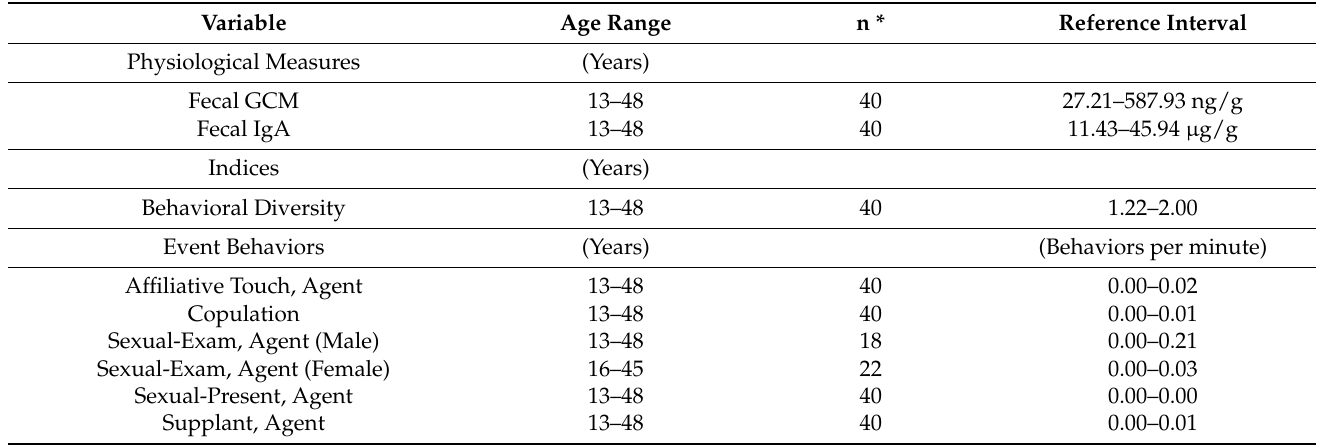
Table 3. General reference intervals for physiological measures, behavioral diversity, and behaviors. General 95% reference intervals are given